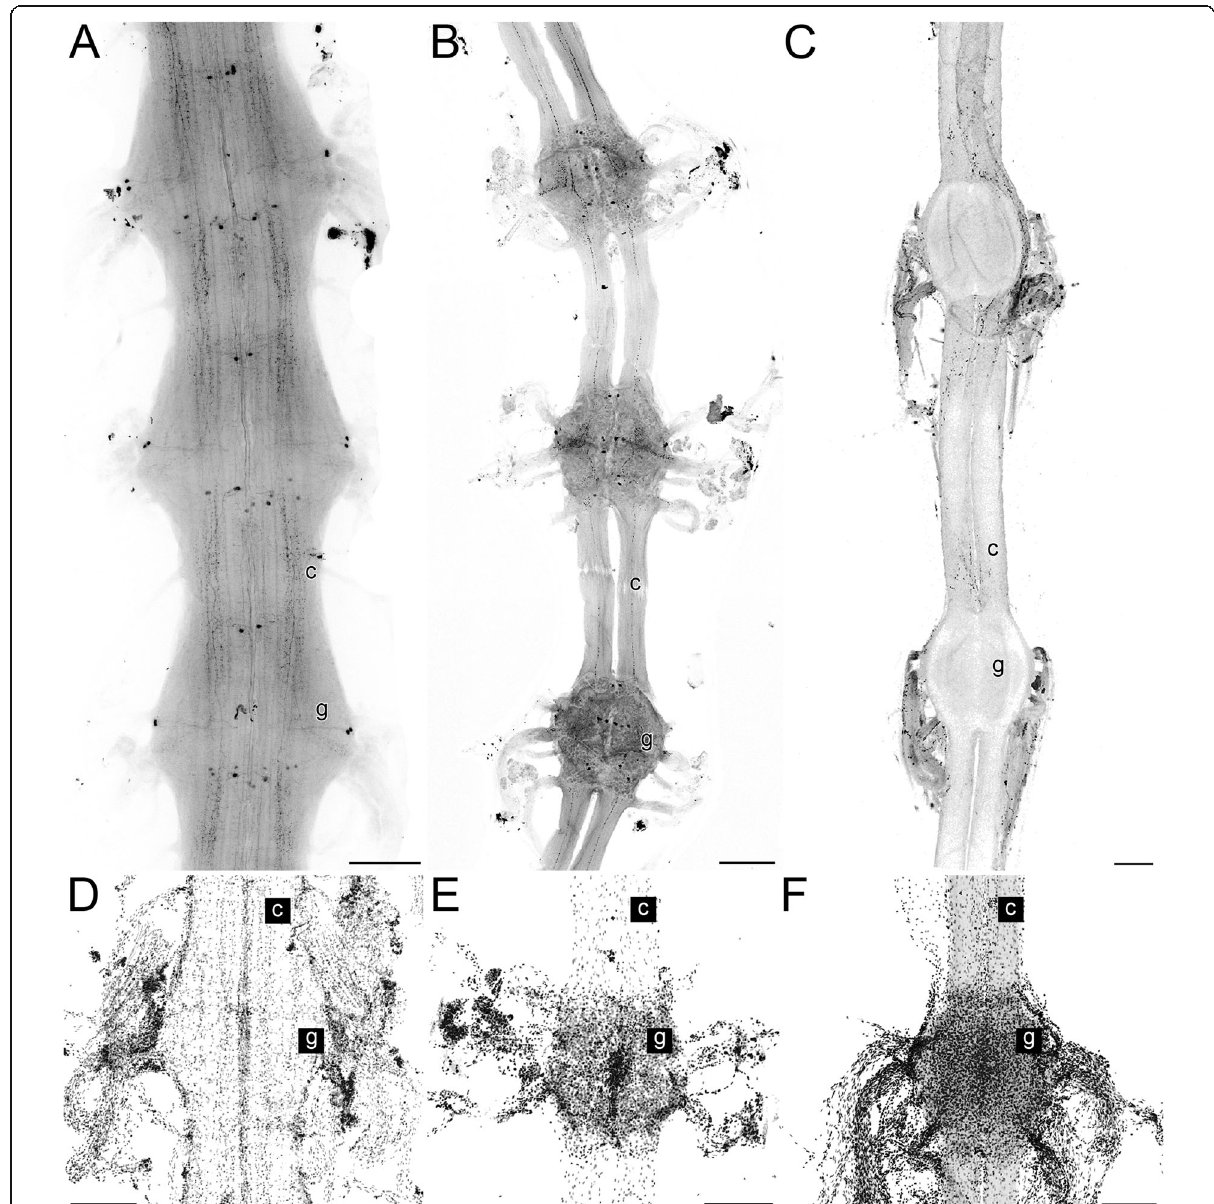
Fig. 2 Centipede ventral nerve cord ganglia (whole mounts) and nuclear labeling of single ganglia. Maximum projections of cLSM stacks, anterior to the top. a Ganglia 9 – 11 of the ventral nerve cord of Scutigera coleoptrata with individually identifiable 5HT-ir neurons. Note the fusion of connectives and segmental organization of leg nerves. b Ganglia of the ventral nerve cord of Lithobius forficatus with individually identifiable 5HT-ir neurons. In contrast to S. coleoptrata , the long connectives are separated. c Ganglia of the ventral nerve cord of Scolopendra oraniensis . As whole mount labeling against serotonin failed, no individual neurons are visible. Note the long connectives. d Nuclear labeling in a ganglion of S. coleoptrata. Note that the density of somata surrounding the ganglia (g) is equal to that around the fused connectives (c). e Nuclear labeling in a ganglion of L. forficatus. Note that the density of somata surrounding the ganglion (g) is much higher than around the connectives (c). f Nuclear labeling in a ganglion of S. oraniensis. Note that the density of somata surrounding the ganglion (g) is much higher than around the connectives (c). Scale bars = 250 μ